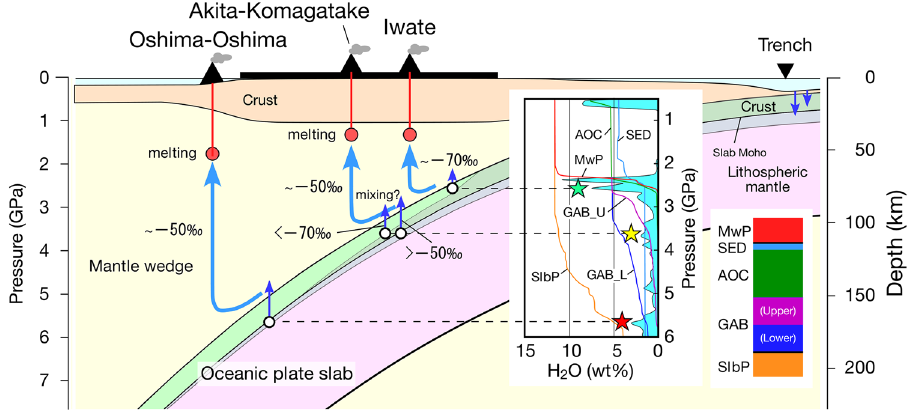
Figure 3. Schematic of the subduction-zone processes in the NE Japan arc. The figure is modified from Fig. 11A of Ref. 42 illustrating the chemical geodynamics in a cold subduction system. The inset, modified from Fig. 2a of Ref. 31 , shows the result of calculations for the NE Japan arc using the Arc Basalt Simulator version 5. Namely, the results show variations in the total amount of H 2 O released from the slab (the cyan area) and in the amounts of H 2 O stored in the individual layers of the subducting slab with depth. MwP denotes the mantle wedge base peridotite layer just above the subducting slab; SED and AOC refer to the sediment layer and the altered oceanic crust layer, respectively; GAB_U and GAB_L denote the upper and lower gabbro layers, respectively; and SlbP refers to the slab peridotite layer. The green, yellow, and red stars indicate the possible main H 2 O sources of the slab fluids for Iwate, Akita-Komagatake, and Oshima-Oshima, respectively. The red circles denote the melt segregation depths obtained by Refs. 43,44 (the segregation depth at